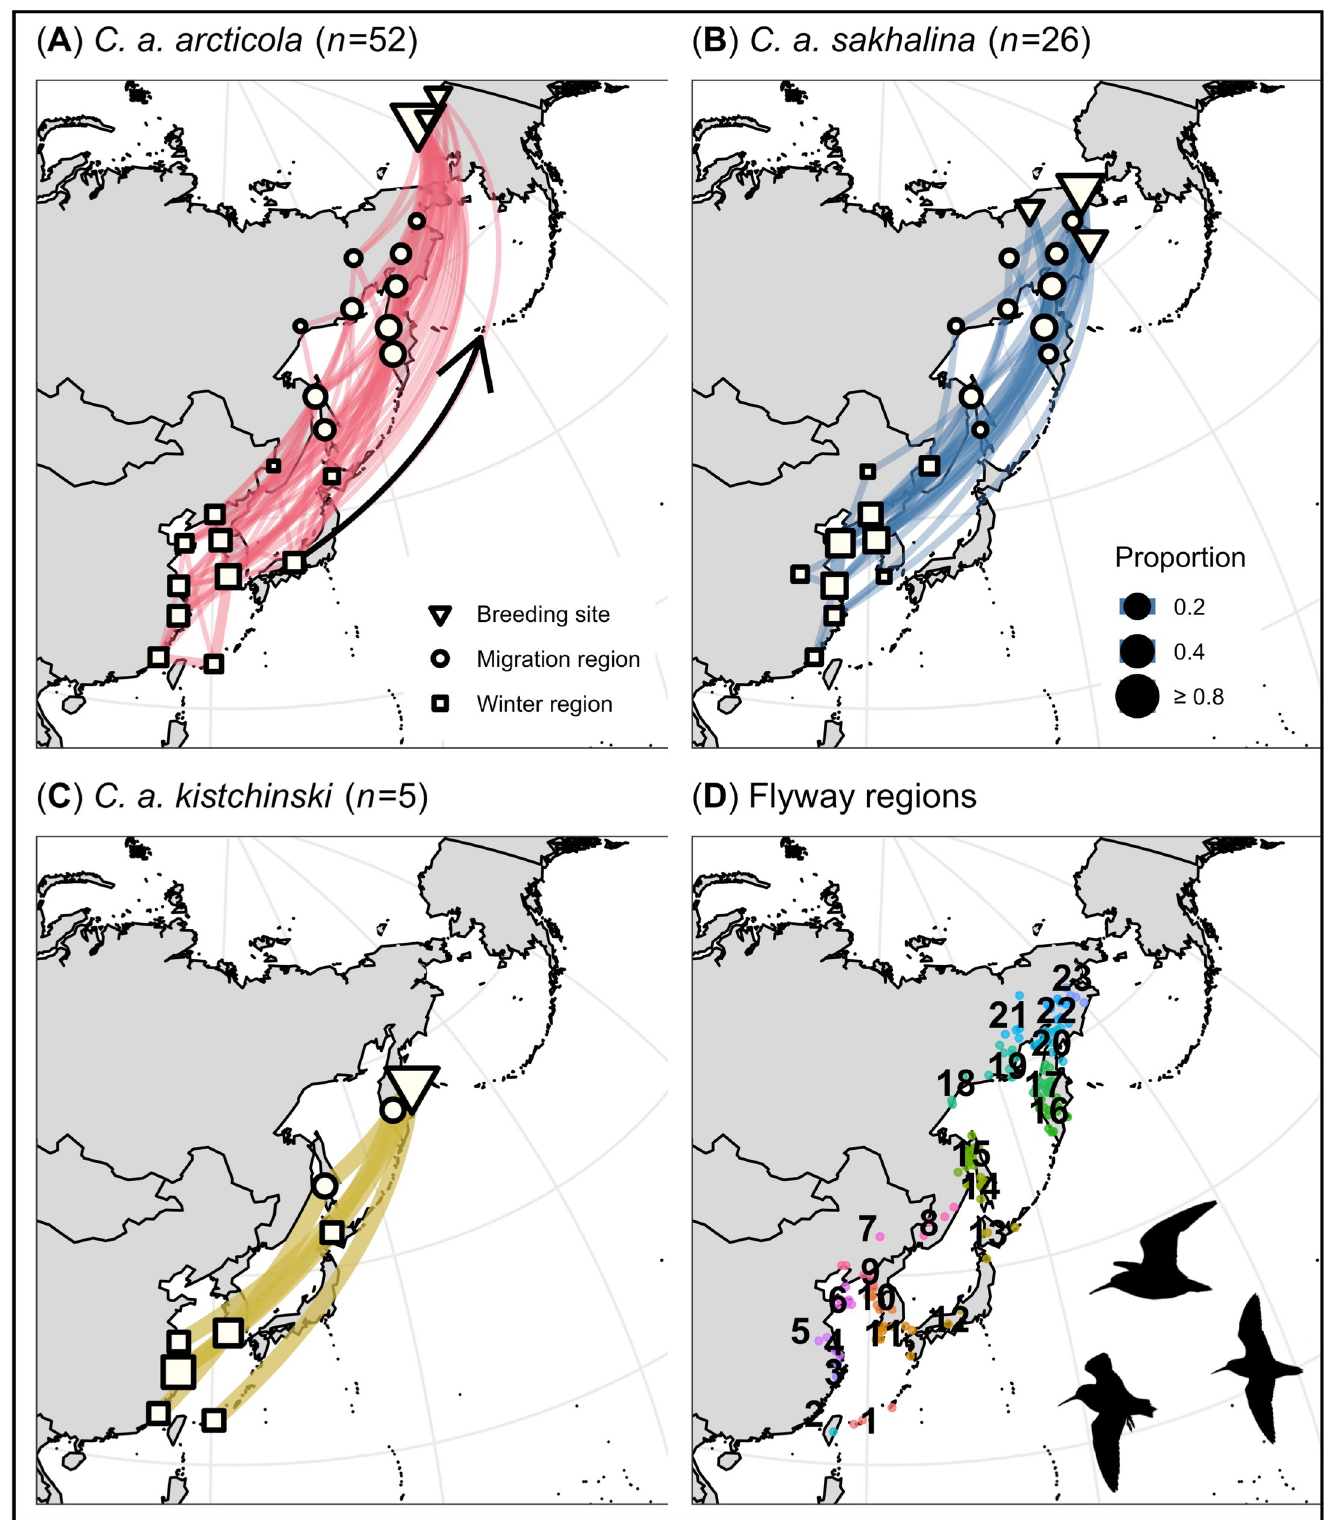
Fig 5. Migratory network depicting north migration movements made by Dunlin subspecies along the East Asian–Australasian Flyway, and (D) north migration stationary estimates color-coded by flyway region. Network nodes and edges are weighted by the proportion of individuals that stopped in each flyway region, and the proportion that migrated between flyway regions,